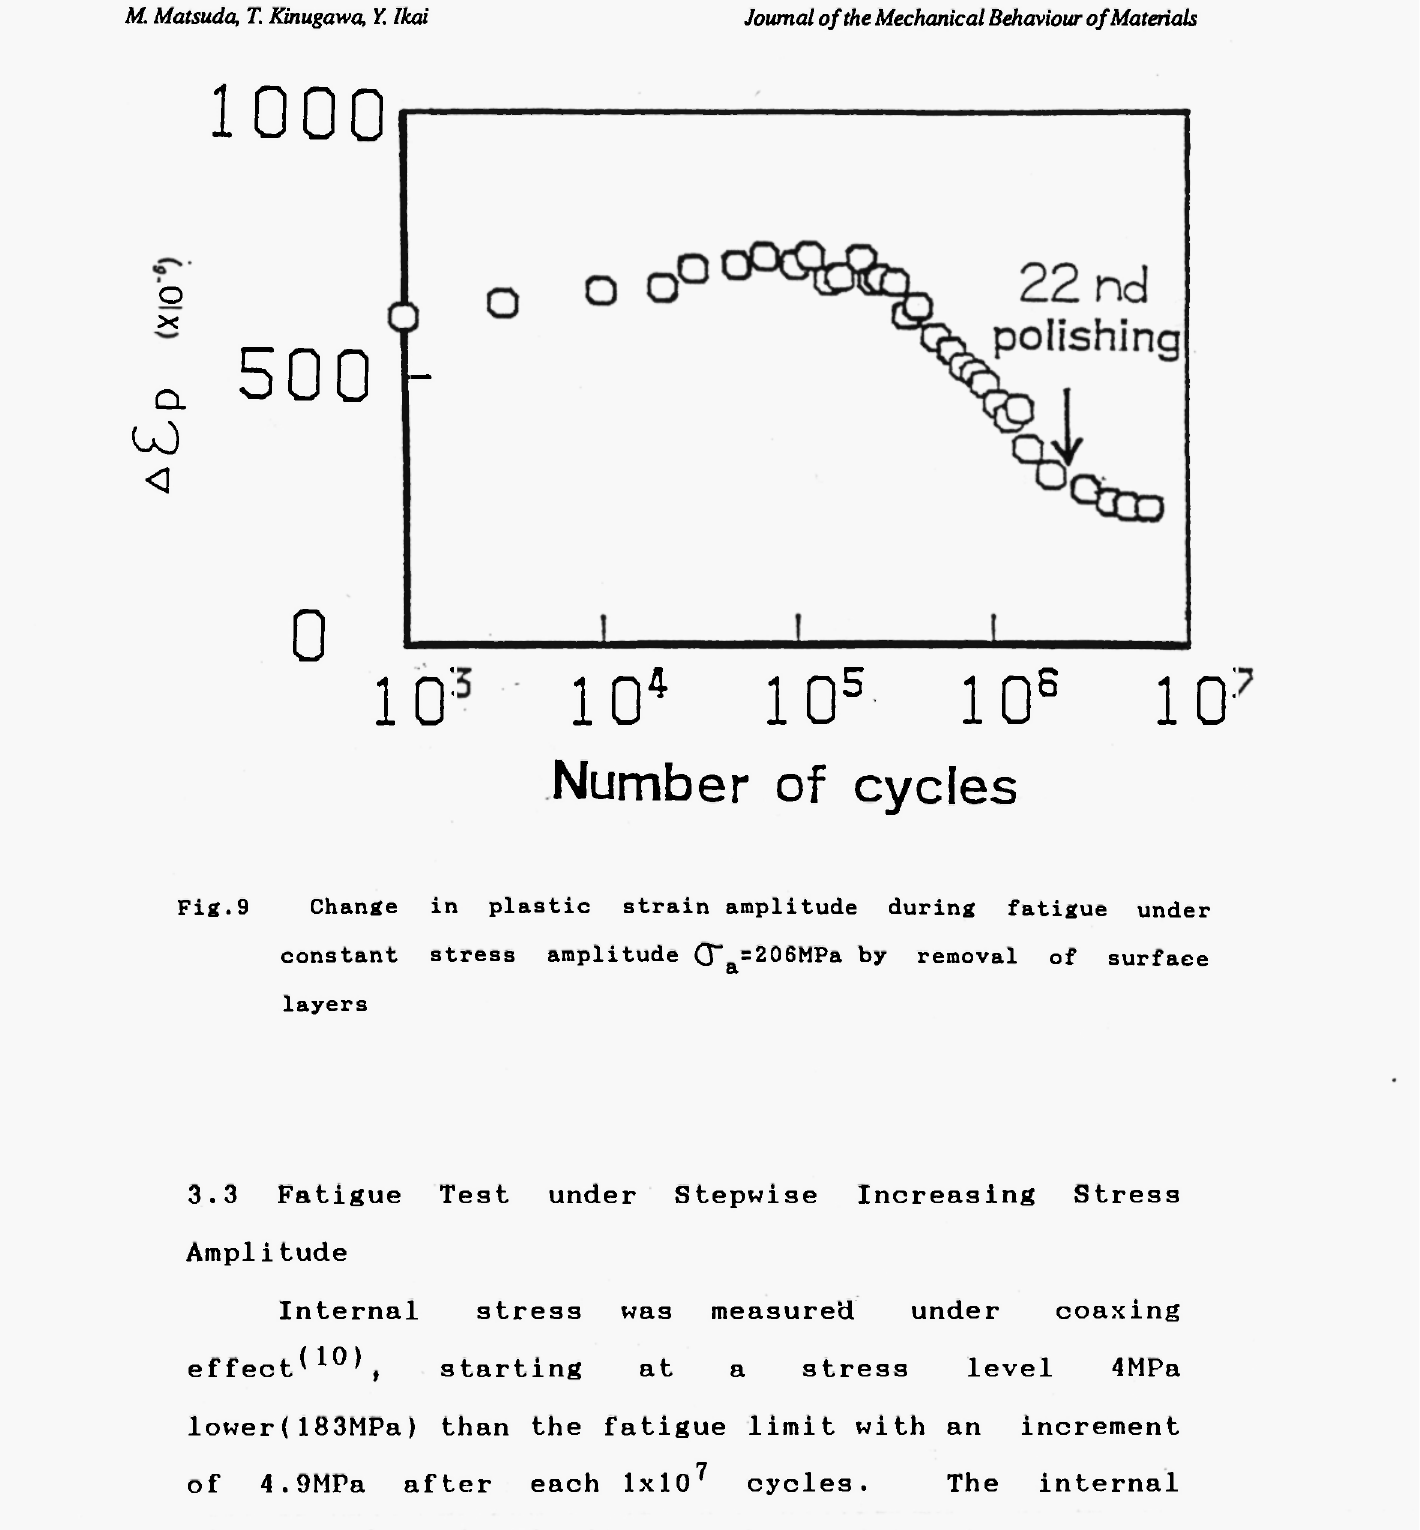
Fig.9 Change in plastic strain amplitude during fatigue under constant stress amplitude O"* a =206MPa by removal of